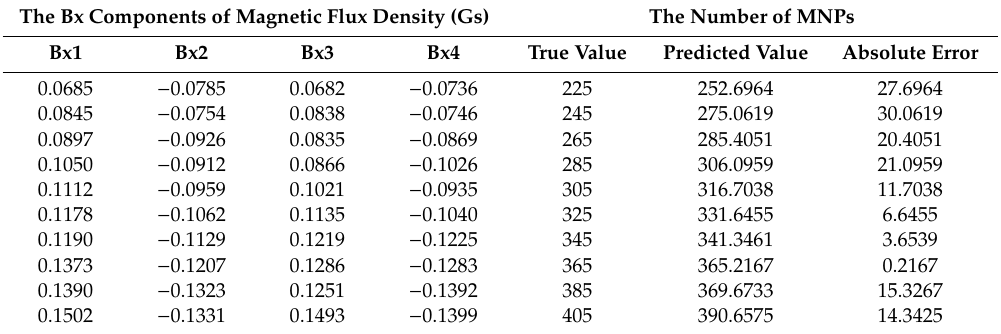
Table 9. Partial prediction results of the number of MNPs through the partial least squares (PLS) model. The Bx Components of Magnetic Flux Density (Gs)